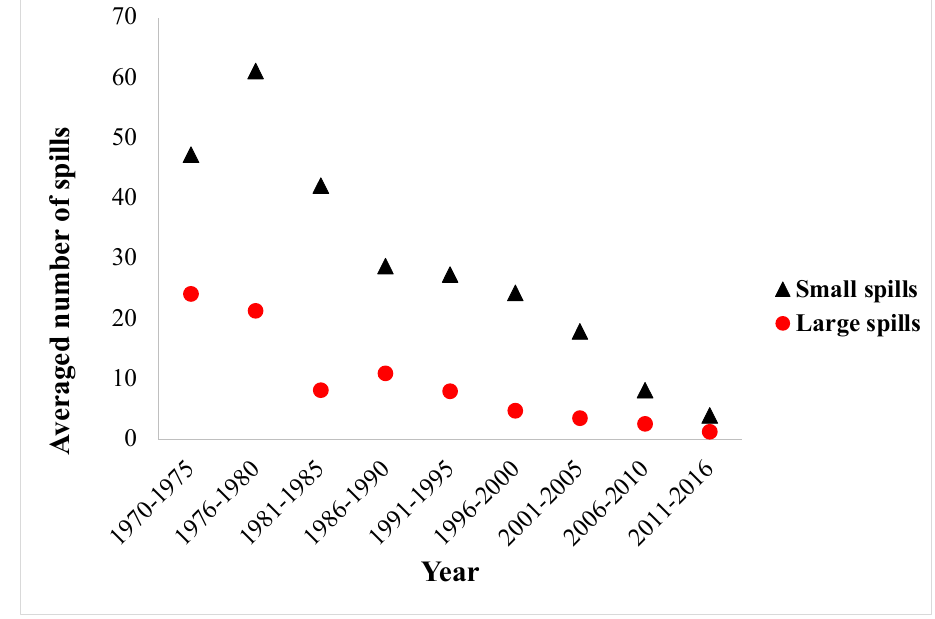
Figure 1. Averaged number of global oil spills from tankers from 1970–2016 [2].